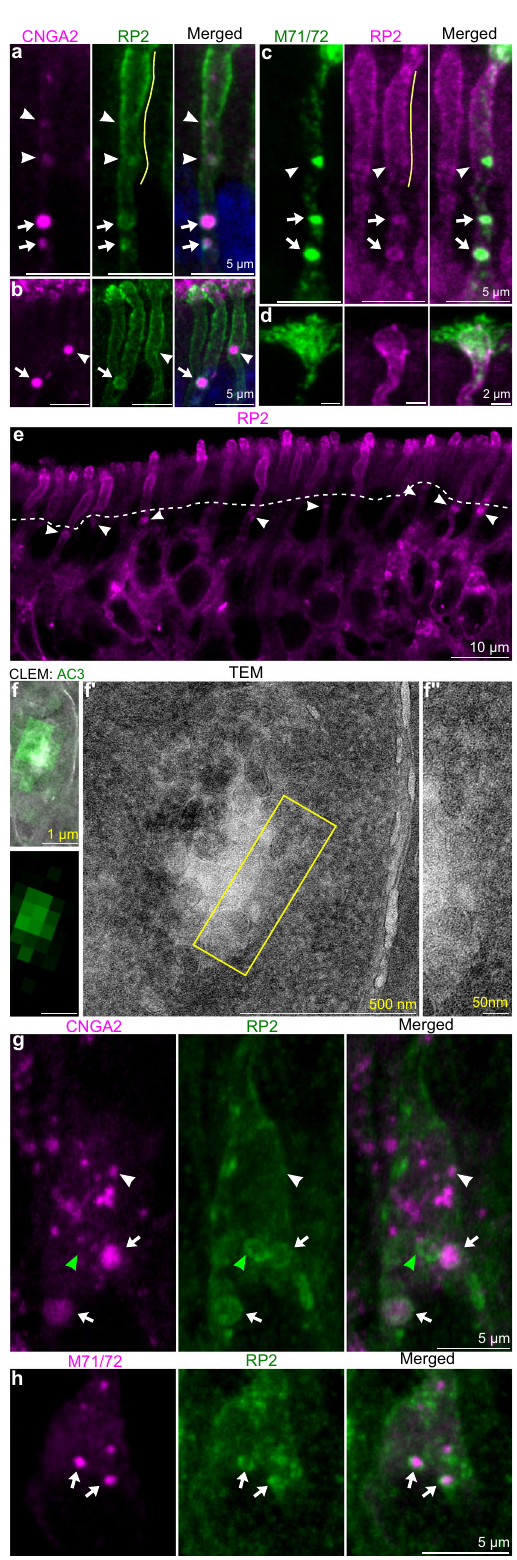
Fig. 7d´) to active (S100A5 + ) OSNs without MVTs (green arrows in Fig. 7d´) in OE on the occluded and non-occluded side. The results showed that narisocclusion increased thepercentage of inactive OSNs (compare the blue and green sectors of the pie charts in Fig. 7e). The naris occlusion effect was evident not only relative to the non- occluded side, but also to OE in control (unoperated) mice. This indicated that doubling of the odor/air stream on the non-occluded